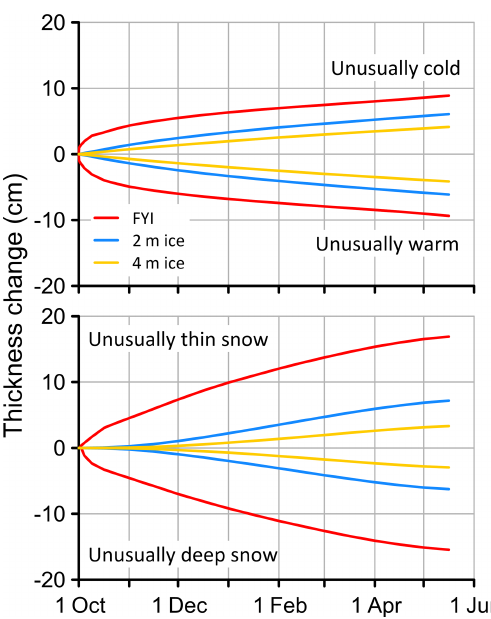
Figure 10. Sensitivity of the calculated ice-growth adjustment to ± 1 standard deviation departure from average climatic conditions for air temperature and snow